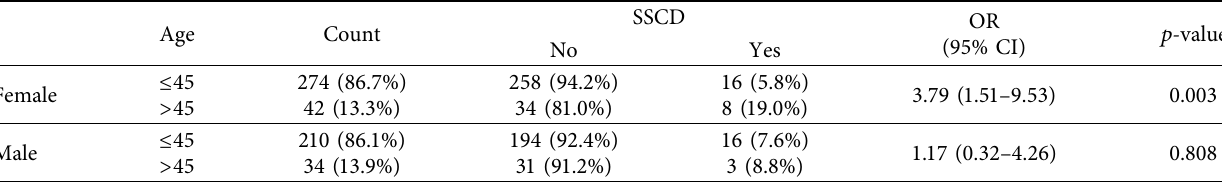
Table 3: Comparison of the participants aged below and above 45 years regarding the prevalence of SSCD.